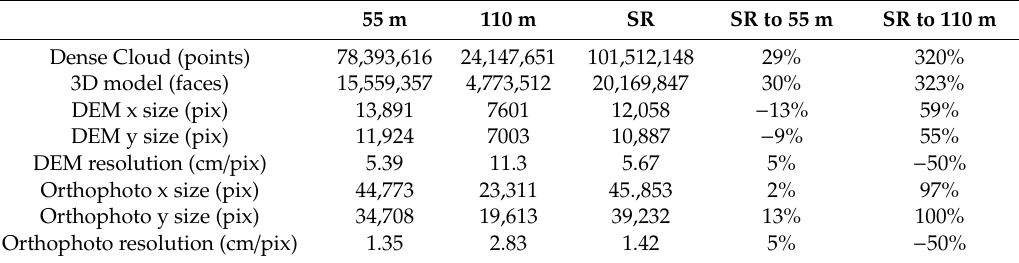
Table 10. Photogrammetric products data summary for the Phantom 4